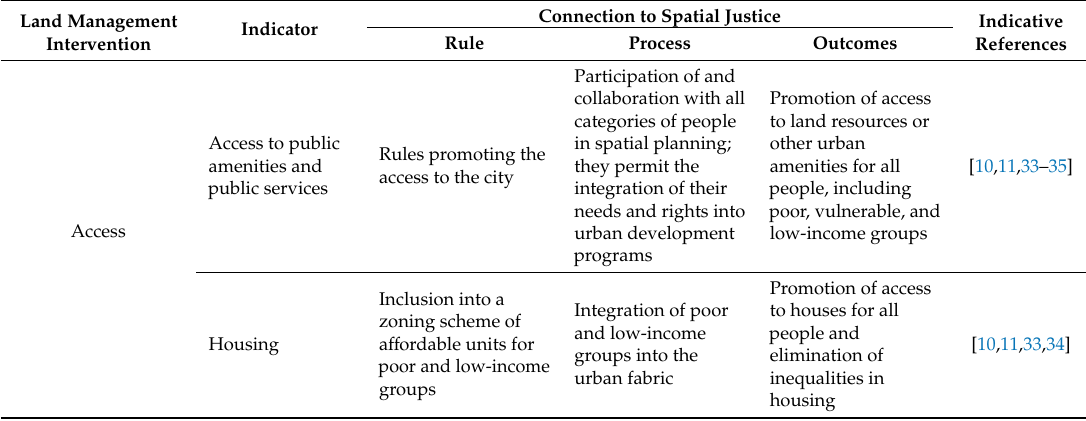
Table 3. Indicators related to access to